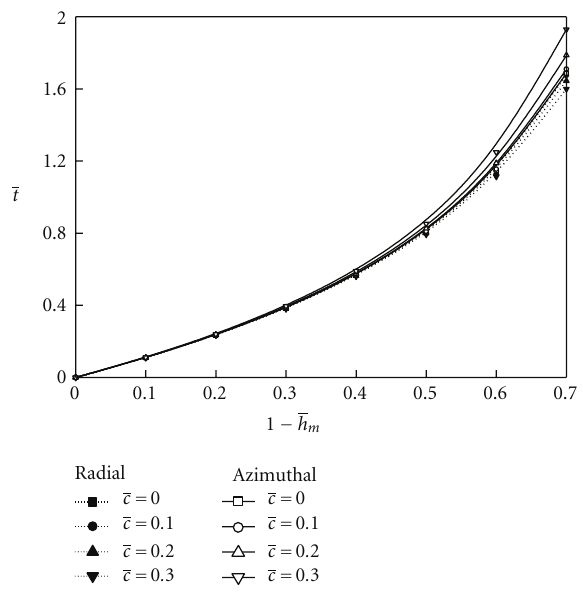
Figure 12: Variation of nondimensional response time t with 1 − h m for di ff erent values of c with β = 0 . 05, M = 2, l = 0 . 3, and ψ = 0 . 01.